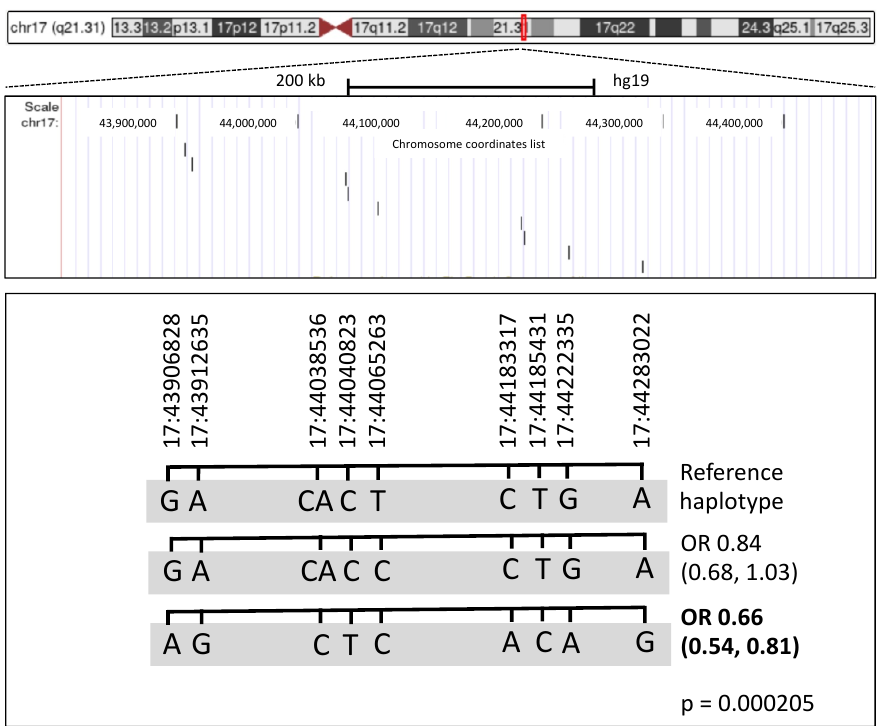
Figure 3. Feature Ranking summary. The Feature Ranking task computes a set of measures to assess the relevance/usefulness of the input attributes within the LLM rules. Absolute relevancy gives an aggregate measure of how “strong” the correlation is between a given input attribute and the output. As expected by the known female predominance of the disease, sex ranked first, and its relevance was 0.81, 11.5 times more relevant than the second feature (the HLA SNP) and 13.5 times more relevant than the third one (the first non-HLA SNP). Among genetic variants, the HLA SNP ranked second, with a relevance of 0.07. Among non-HLA variants the best ones were chr19:50924093 (SPIB) (0.06), chr3:119111870 (TIMMDC1) (0.06) and chr2:191943742 (STAT4) (0.05).